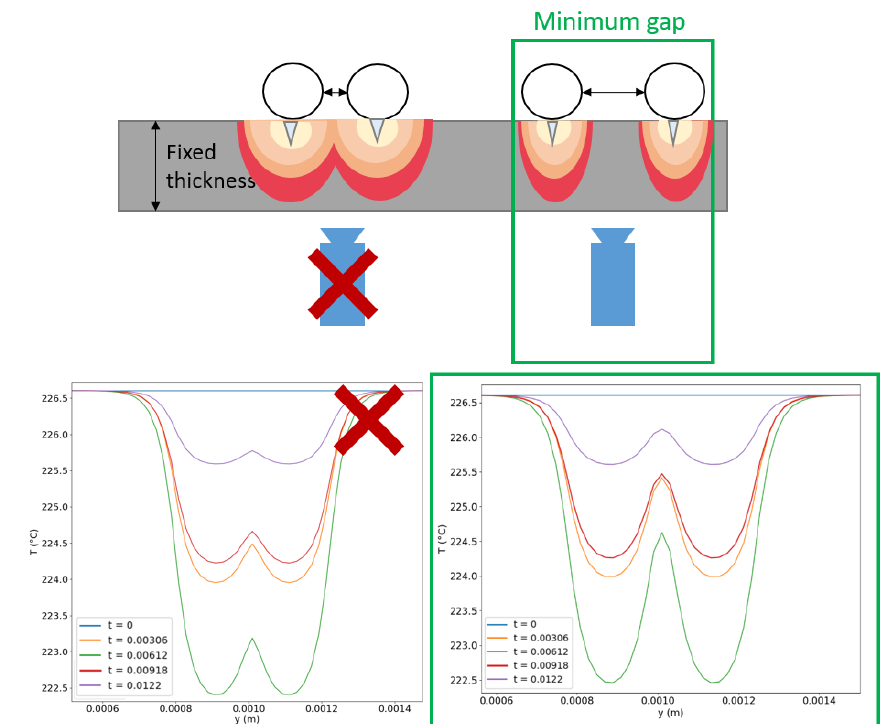
Figure 22. Example of the determination of the minimum gap for two bubbles to be discernible. For the first example ( left ), the bubbles are too close, and the temperature on the dry side will not allow discretizing two objects except for one big bubble growing on the plate. For the second example ( right ), after expanding the distance between the bubbles, the temperature field allows detection of two different